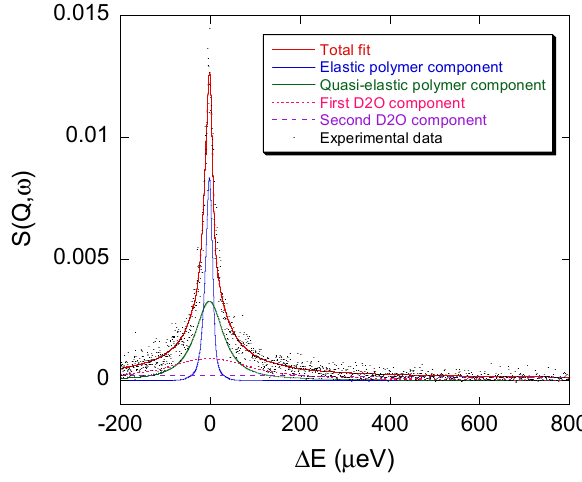
Figure 8. Quasi-elastic incoherent neutron scattering (QENS) spectrum at 283 K and Q = 0.7751 Å − 1 . The experimental data, total fit and single components are shown.